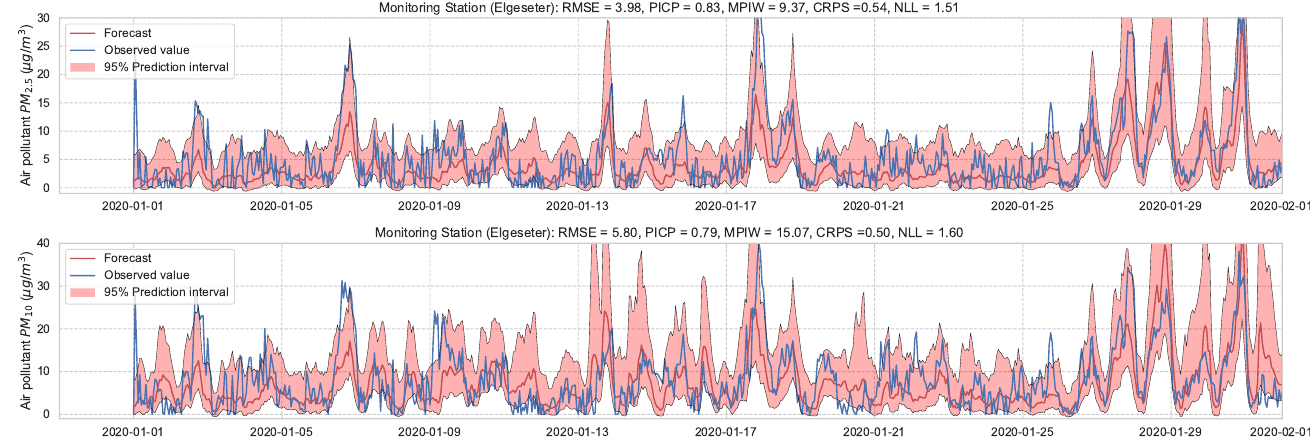
Figure 19. Probabilistic forecasting of multivariate time-series air quality using a GNN model with MC